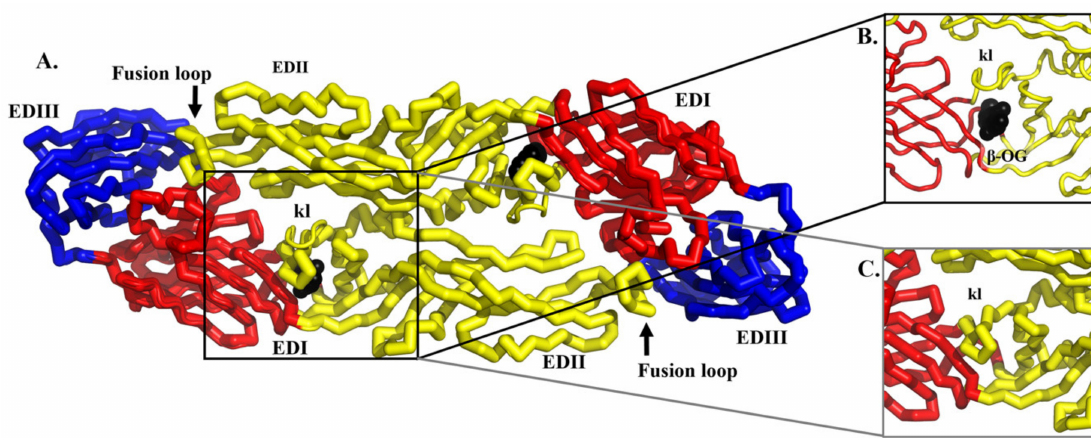
Figure 7. The superimposition of the structures of DENV2 E protein in the absence (ribbon) and presence (tube) of a detergent molecule. ( A – C ) The detergent molecules β -OG are shown in black. The domains of the E protein were labelled as EDI, EDII and EDIII, and colored as red, yellow and blue, respectively. The fusion loop is indicated by an arrow and labelled. The kl hairpin is labelled. The key di ff erence between the two structures is the position of the kl hairpin. ( B ) In the presence of detergent, the kl hairpin will open up the hydrophobic pocket under the kl hairpin and the detergent can bind to the hydrophobic pocket (PDB ID: 1OAM). ( C ) In the absence of detergent, the kl hairpin is in the “closed position” and the hydrophobic amino acids are buried in the pocket (PDB ID: 1OAN). The figure was modified from Modis et. al. (2003)